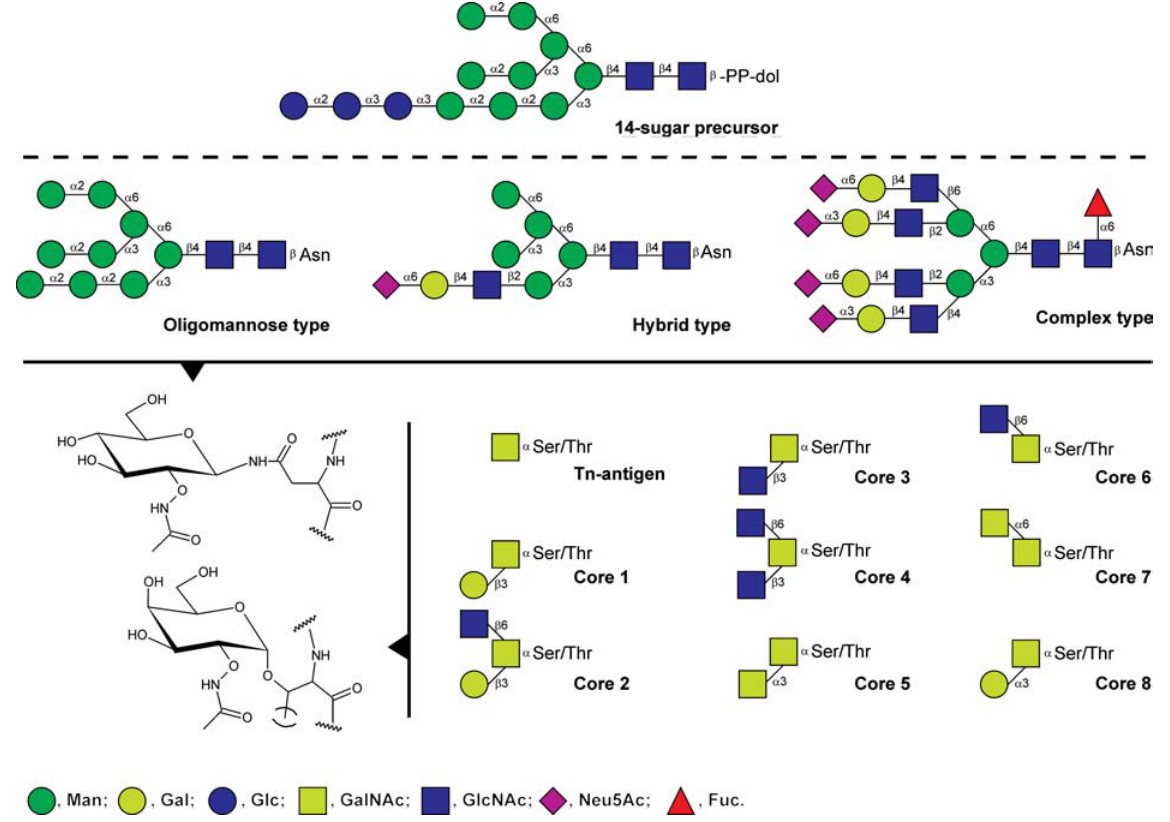
Figure 2 Short-hand notation for the two most frequently occurring types of glycosylation. The top panel depicts N-type glycans, with the 14-residue dolichol pyrophosphate precursor above the dashed line. Below the dashed line are depicted oligomannose type (left), hybrid type (center), and complex type glycans (right). On the bottom panel on the lower-right, the eight known mucin-type O-glycan core structures are depicted. The symbols are from the Consortium for Functional Glycomics (CFG;